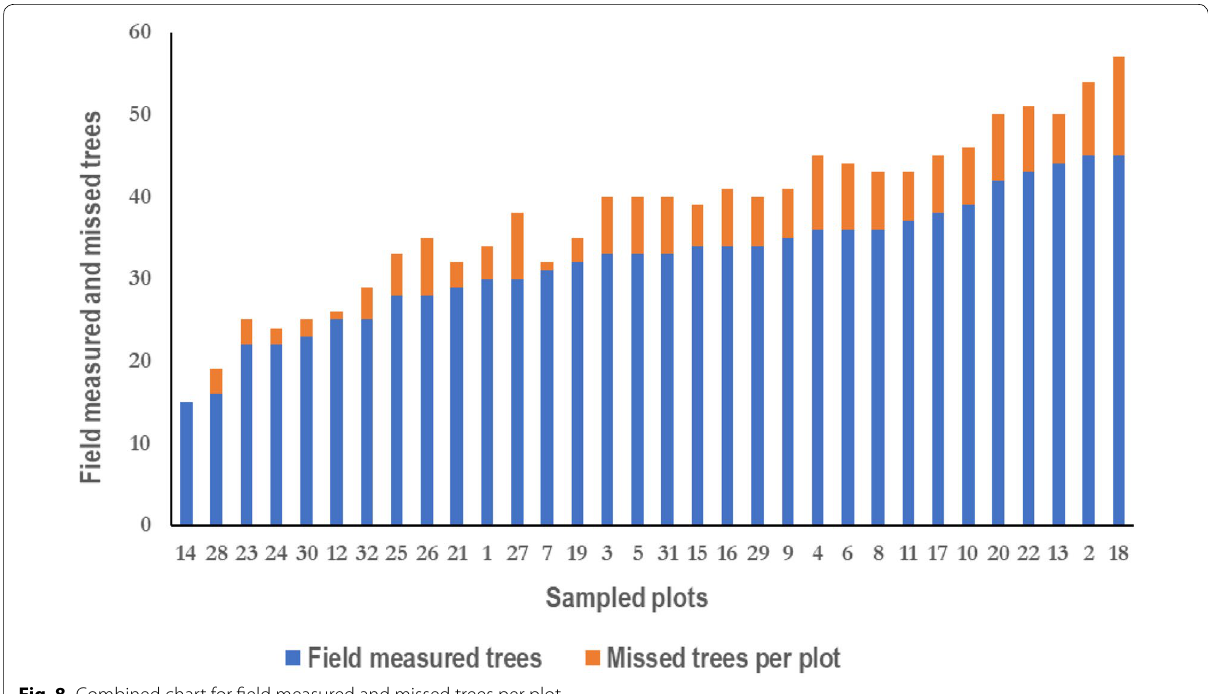
Fig. 8 Combined chart for field measured and missed trees per